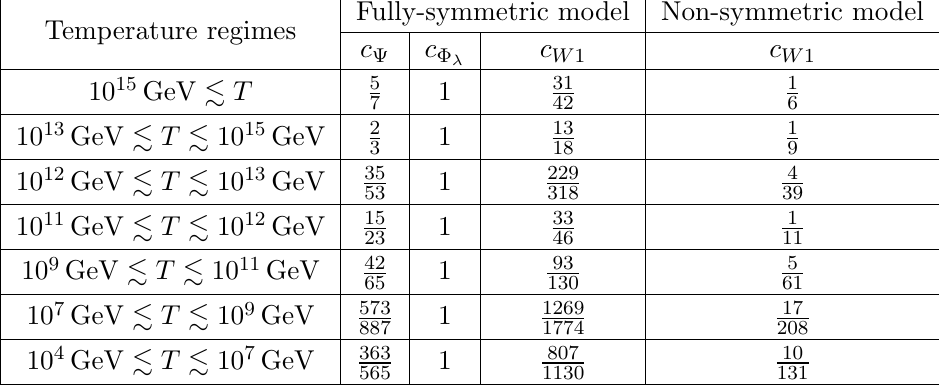
Table 6 . We list the values of c (cid:9) , c (cid:8) the fully-symmetric model , as well as the values of c W 1 = 1 simplicity, in our numerical estimations, we will (cid:12)x c W 1 = 0 : 7(0 : 1) for all temperature regimes in the fully-symmetric (non-symmetric) model